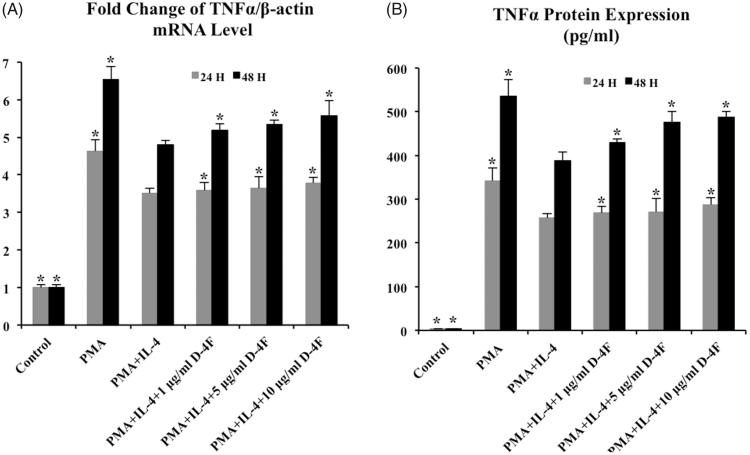
D-4F increases TNF-α transcription and translation in IL-4 induced M2 macrophages. Compared to the cells treated with IL-4 alone, when cells were treated with IL-4 and D-4F (1, 5 and 10 μg/mL), (A) RT-PCR showed that the relative mRNA levels of TNF-α increased 2%, 4% and 8% in 24 h incubation (grey bar) and increased 8%, 11% and 16% in 48 h incubation (black bar) and (B) ELISA analysis demonstrated that the TNF-α protein expression increased 4%, 6% and 12% in 24 h incubation (grey bar) and increased 11%, 22% and 26% in 48 h incubation (black bar). Asterisk indicated significant difference (p ≤ 0.05) when comparing to the cells treated with PMA and IL-4 (MDMs with the highest level of alternative activation).